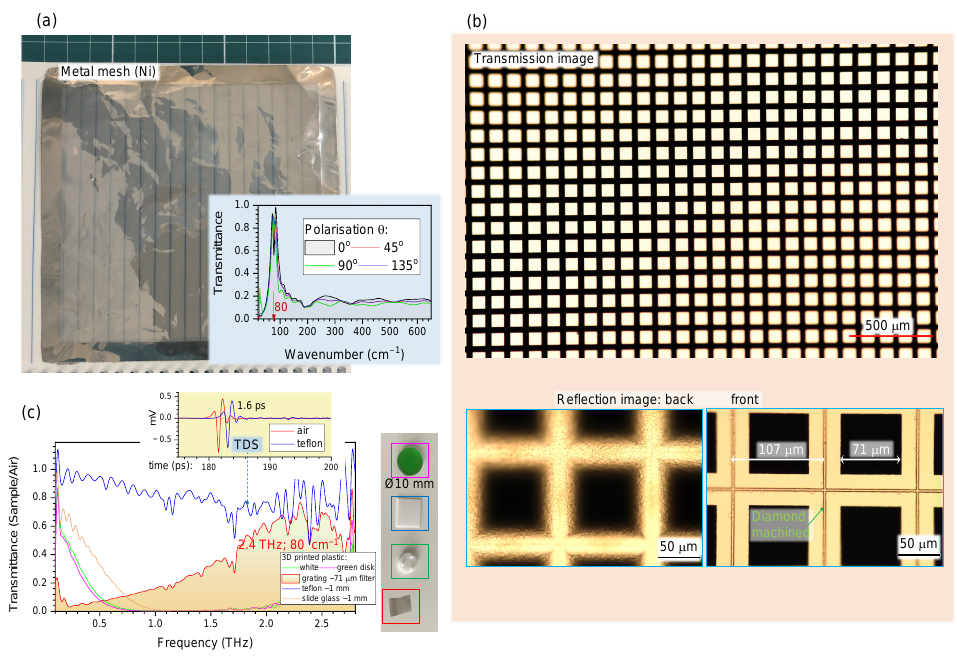
Figure A4. ( a ) Ni-mesh THz filter. Background lines are from a ruled notebook. ( b ) Optical mi- croscopy images of segments from 20 × 20 cm 2 Ni plated micro-mesh at different magnifications. Inset shows THz transmittance spectra of the ∼ 2.4 THz (˜ ν = 80 cm − 1 ). ( c ) THz time domain spec- troscopy (TDS; TDS10XX Batop optoelectronics) spectra (at room conditions) of several materials promising for THz optical elements. The TDS spectra reveals details at the 0.1–1 THz band. Top-inset shows time domain data for 1-mm-thick teflon which cause ∆ t = 1.6 ps delay as compared with air. Different Mylar beamsplitters are used to select the spectral window for measurements, tailored for broadband and narrow spectral regions at low wavenumbers ˜ ν < 50 cm − 1 (Figure A1). The beamspliter is an integral part of the FTIR spectrometer and is installed be- fore the sample compartment. For the broadest spectral characterisation of filters, the 6 µ m Mylar beamsplitter was used in this study (Figure